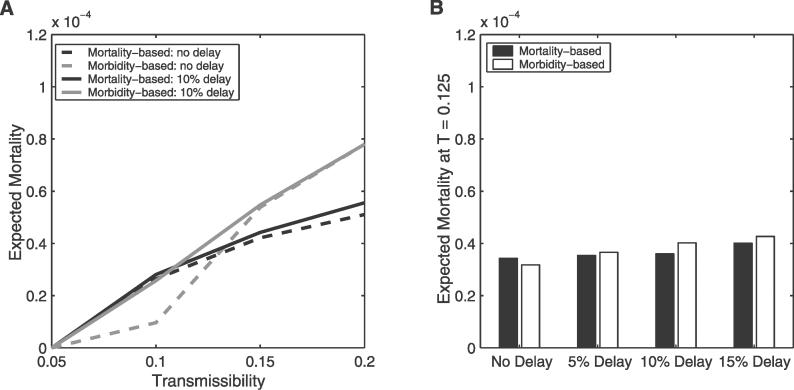
The Epidemiological Impact of Delayed Vaccination(A) The morbidity-based strategy is more effective than the mortality-based strategy when T is less than 0.13 only if there is there is no delay in vaccination. When vaccines are given after 10% of the population has already been infected, the morbidity-based strategy becomes relatively less effective (and is the preferred strategy only when T is less than 0.11).(B) At T = 0.125, the morbidity-based strategy is superior to the mortality-based strategy when there is no delay, but inferior for any amount of delay. Each of the values is an average taken across 500 epidemic simulations on the contact network.